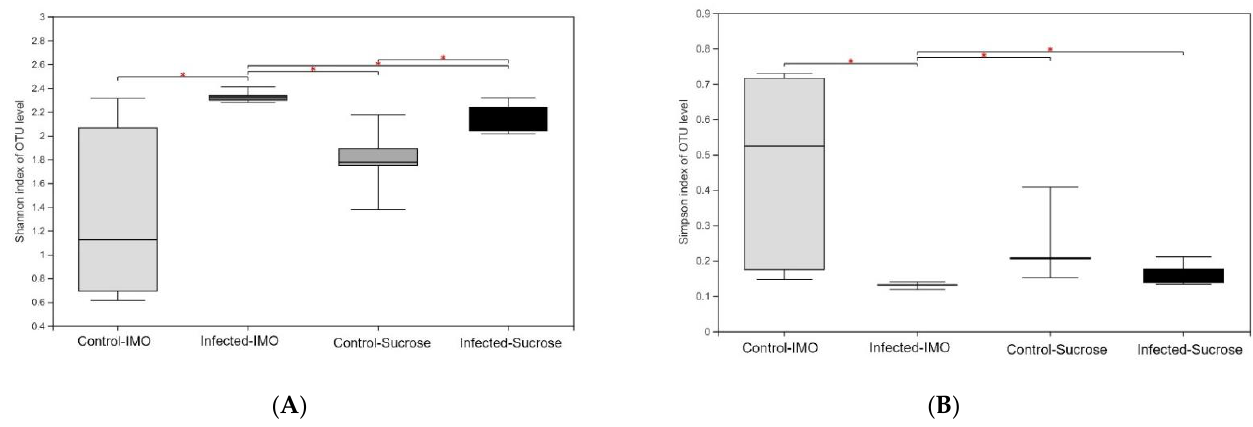
Figure 6. Alpha diversity analyses. ( A ) Shannon index. ( B ) Simpson index. The infected group receiving IMO had a significantly higher Shannon index value (2.329, p = 0.012) and lower Simpson index value (0.130, p = 0.012). Significances ( p < 0.05) are labeled by